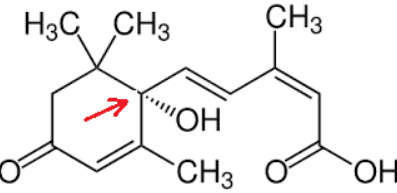
Figure 1. Structure of ABA. 2-cis, 4-trans-Abscisic acid has an asymmetric carbon atom (arrow) generating two enantiomers S-( + )-ABA and R-(-)-ABA. ( + )-ABA is the naturally-occurring form in plants, although (-)-ABA is active in some vegetal functional assays [2].